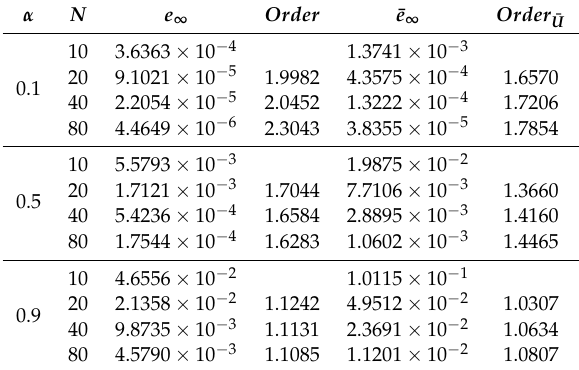
Table 1. e ∞ , ¯ e ∞ and convergence orders, related to the numerical solutions U n for different values of N and α , with J =